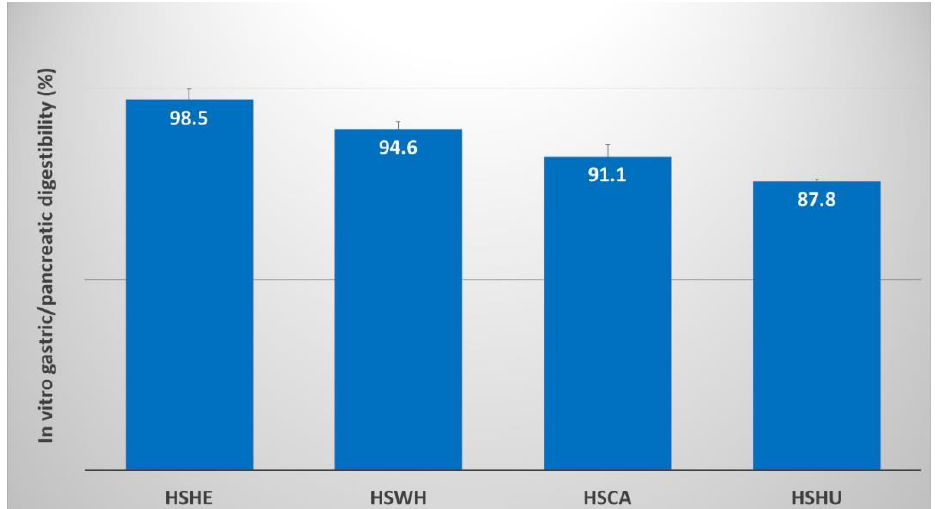
Figure 4. Two-phase in vitro gastric/pancreatic protein digestibility (IVPD) of protein isolates (PIs) extracted from hemp seed and by-products. Data are expressed as the means ± SD (n = 4). HSHE — hemp hearts; HSWH — hemp whole seed; HSCA — hemp cake; HSHU — hemp seed hulls.